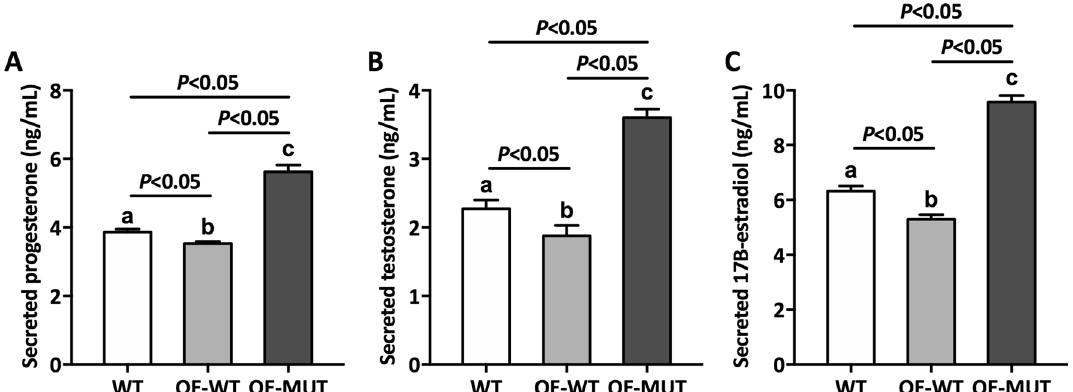
Figure 5. Secreted hormone levels of transfected and non-transfected cells. ( A ) Secreted progesterone level, ( B ) Secreted testosterone level, and ( C ) Secreted 17B-estradiol level. WT: Wild-type cells, OE-WT: Cells overexpressing normal NR0B1 , OE-MUT: Cells overexpressing variant NR0B1 . Error bars represent the standard deviation from triplicate samples. Different lowercase letters represent the significance of differences at P <